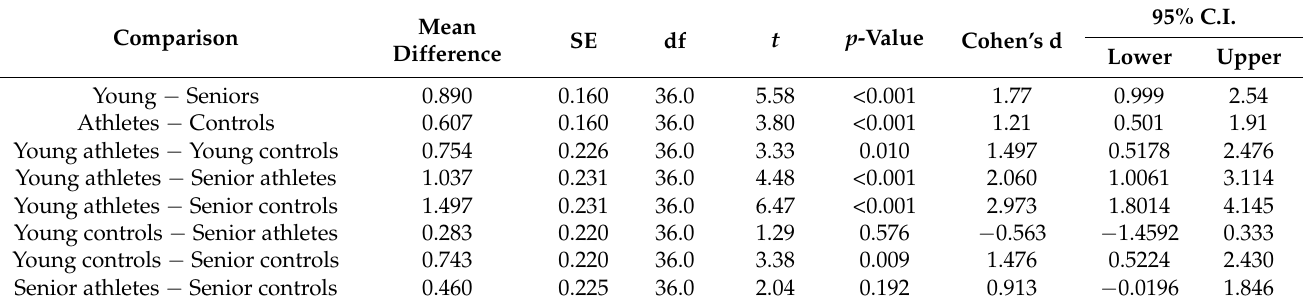
Table 8. ANOVA results for maximum